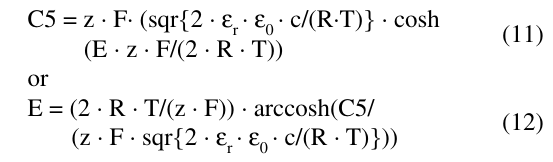
Table 5. Result derived from C5-R6, the »primary layer«, using circuit #1. The ratio of free to blocked area in the »secondary la- yer«, a , is calculated assuming that the »true« thickness of the p,sec »primary layer« is 3 nm. See text for details. Time K LiCl